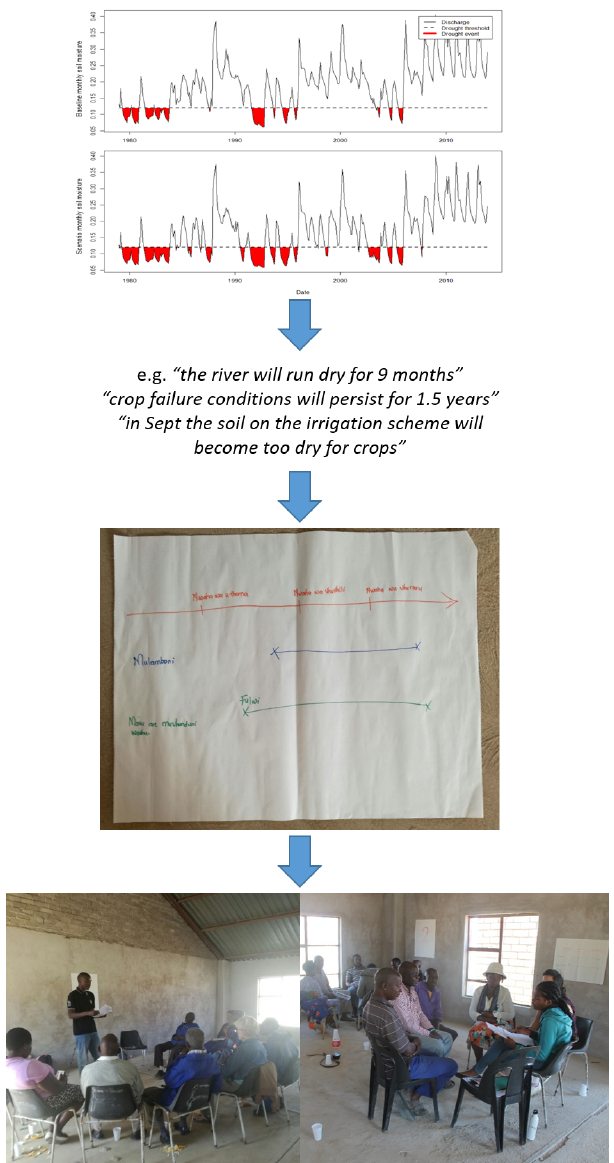
Figure 5. The process of translating the model scenario results into storylines in the local language that were then explained to the workshop participants by the research assistants (photographs by Sally